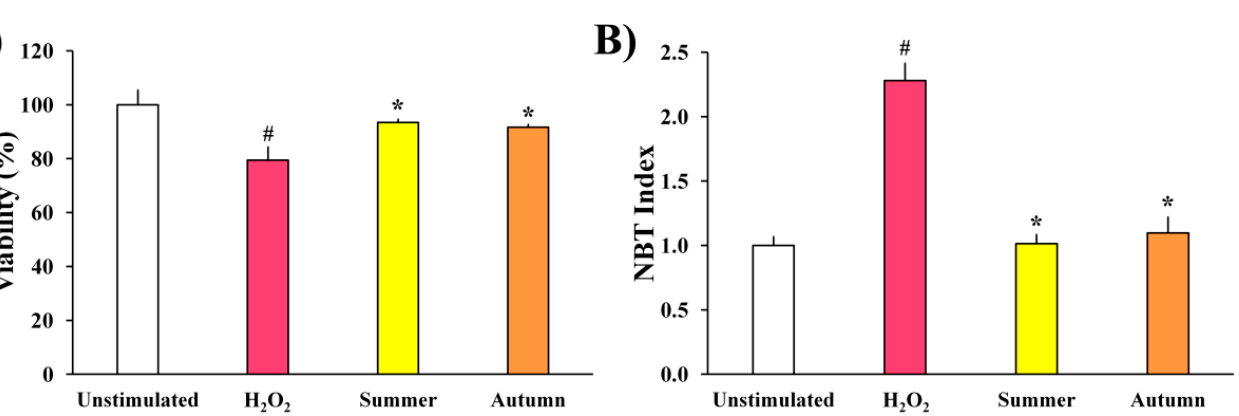
Figure 2. The effects of H. cupressiforme ethyl acetate extracts from different seasonal aspects (sum- mer and autumn) on ( A ) metabolic activity and ( B ) ROS production in H 2 O 2 -stimulated BV2 microglial cells. The results are presented as the mean ± standard error (# p < 0.05 unstimulated cells vs. H 2 O 2 -stimulated; * p < 0.05 H 2 O 2 -stimulated vs. moss-treated and H 2 O 2 -stimulated cells).